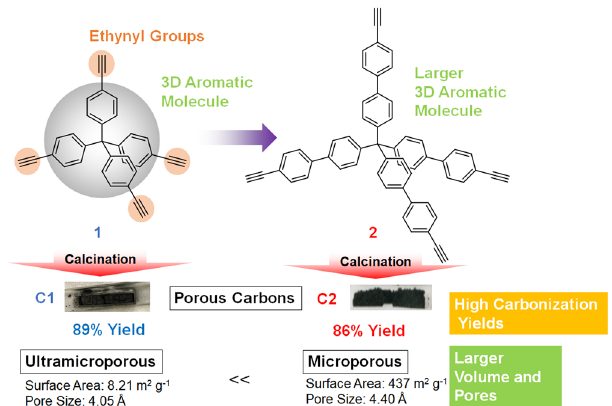
Fig. 1 Molecular design of carbon sources. Carbon sources ( 1 and 2 ) with three-dimensional (3D) aromatic molecules and thermally polymerizable ethynyl groups. Carbonization of these carbon sources afford carbon materials with controlled pore sizes at the Ångstrom level ( C1 and C2